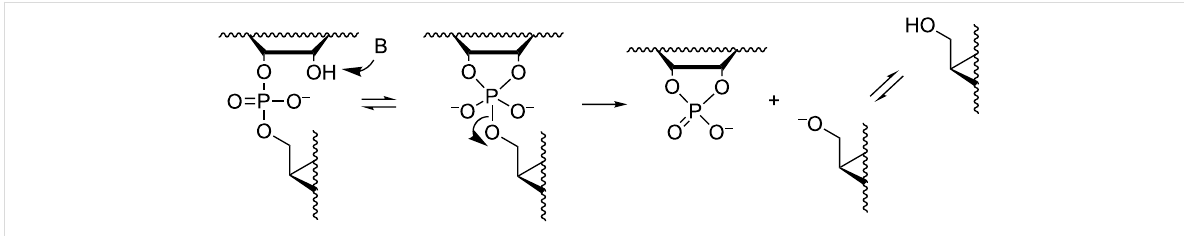
Scheme 5: General base-catalyzed cleavage of RNA phosphodiester bonds.